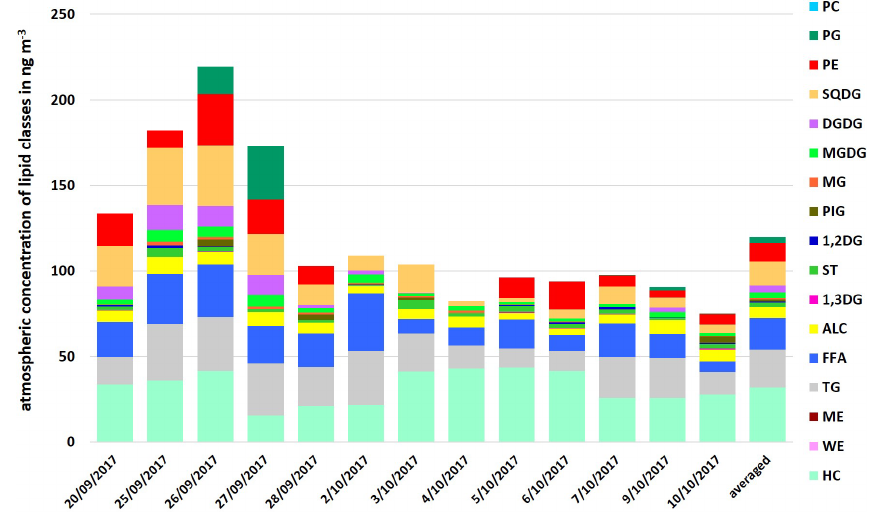
Figure 3. Atmospheric concentration of individual lipid classes in PM 1 aerosol particle samples and as an average at the CVAO in ngm − 3 .